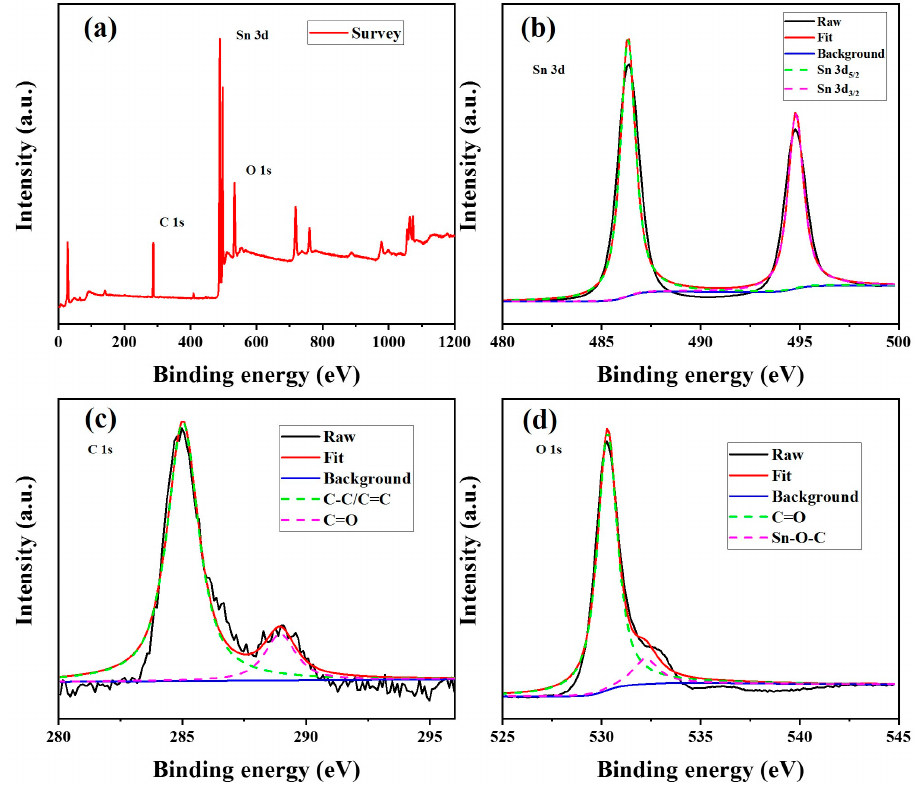
Figure 4. ( a ) XPS survey spectra of SnO 2 -CNFi and high-resolution XPS peaks of ( b ) Sn 3d, ( c ) C 1s and ( d ) O 1s. and ( d ) O